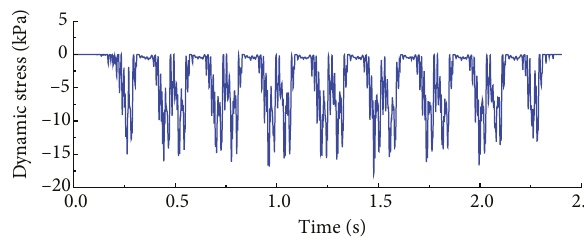
Figure 14: Calculated time history of vertical dynamic